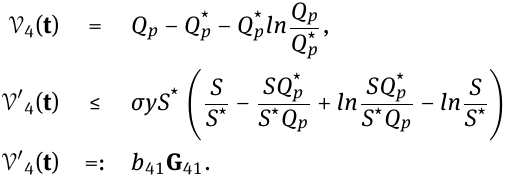
Figure 2: Edge weighted digraph ˇ G for the system (1)